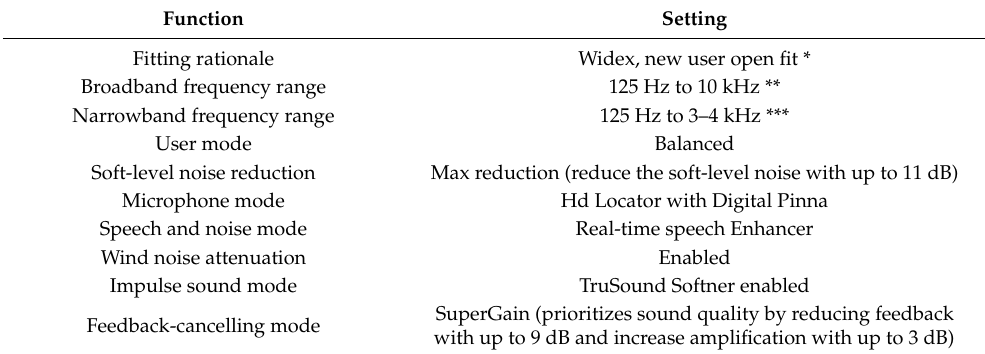
Table 1. Overview of the Widex Evoke Passion 440 hearing aid settings used in the present